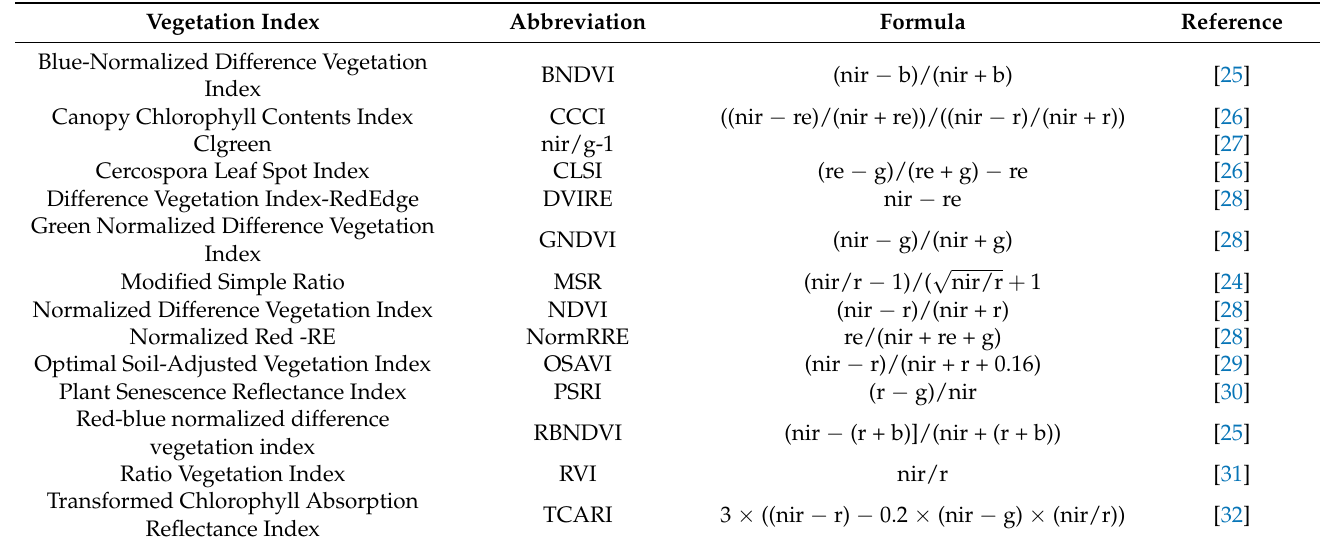
Table 2. Spectral features for monitoring powdery mildew of rubber trees in this